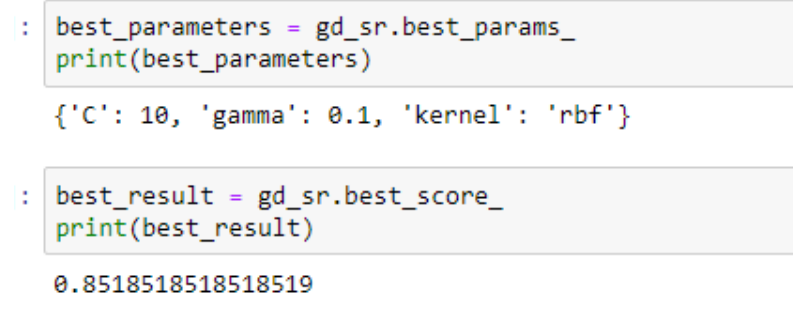
Figure 28. The best parameters with obtained after performing grid search with 10-Fold Cross-Validation on the SVM-RBF model.